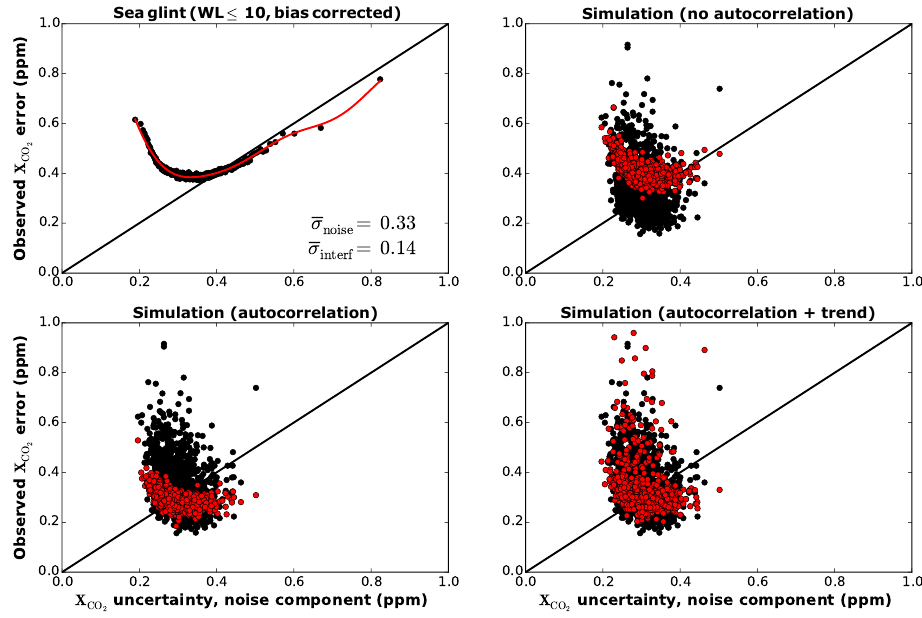
Figure 3. Observed and modeled distributions for sea-glint data.